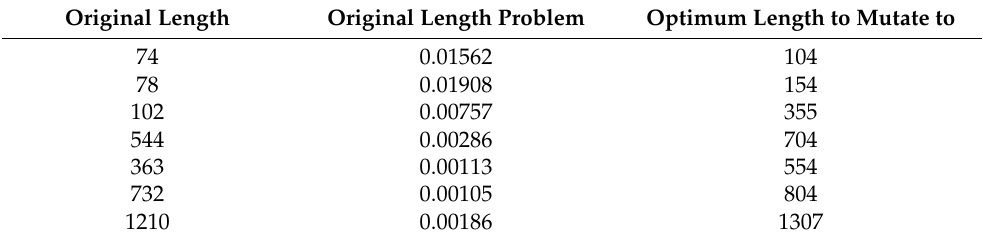
Table 7. Sample of length mapping of Game App, using